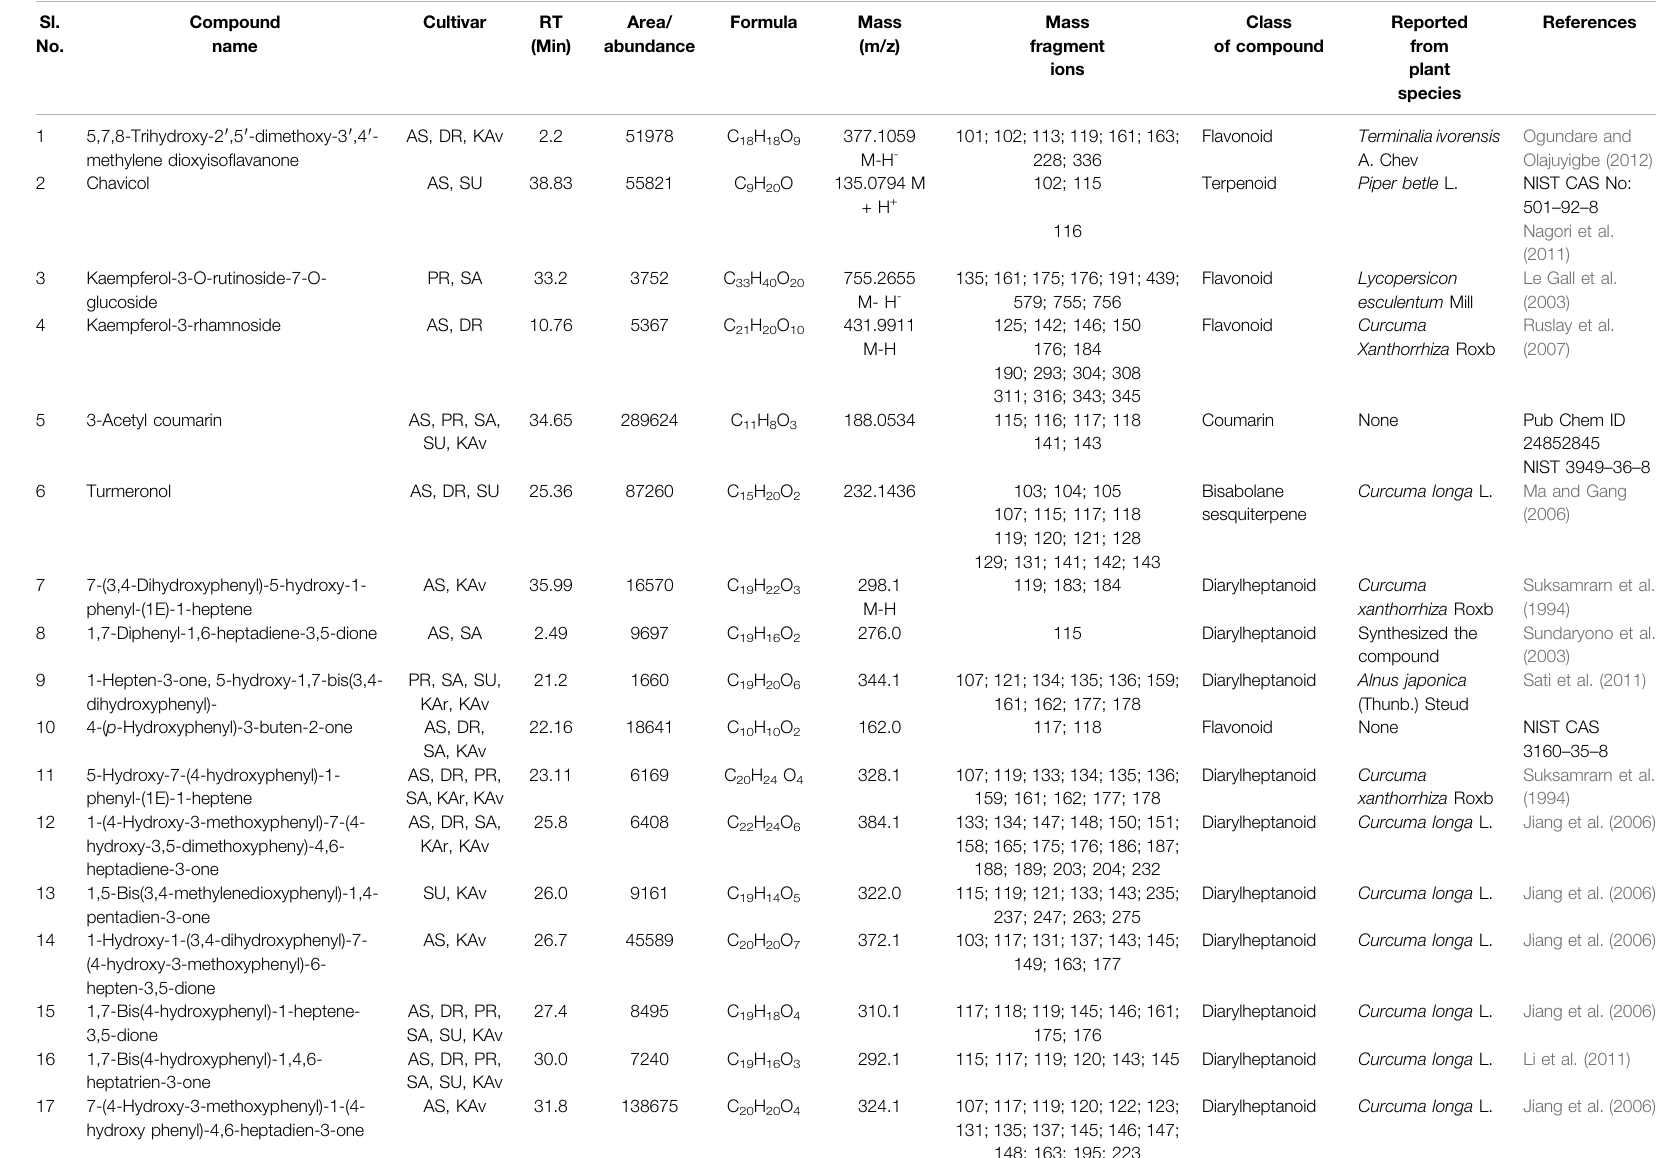
TABLE 7 | Compounds identi fi ed by LC-MS in rhizome extracts of more than one cultivar of Curcuma longa L. and C. aromatica Salisb. The compounds from serial numbers 1 – 3 are reported fi rst time from the genus Curcuma , the structures of these compounds along with few others are given in Figure 2 (panels: 37 – 39; panels 1 – 2, 4, 12 corresponding to serial numbers 4 – 5, 6, 7). Abbreviations used: AS, Alleppey Supreme; DR, Duggirala Red; PR, Prathibha; SA, Salem; SU, Suguna; KAr, Kasturi Araku; KAv, Kasturi Avidi. Sl.